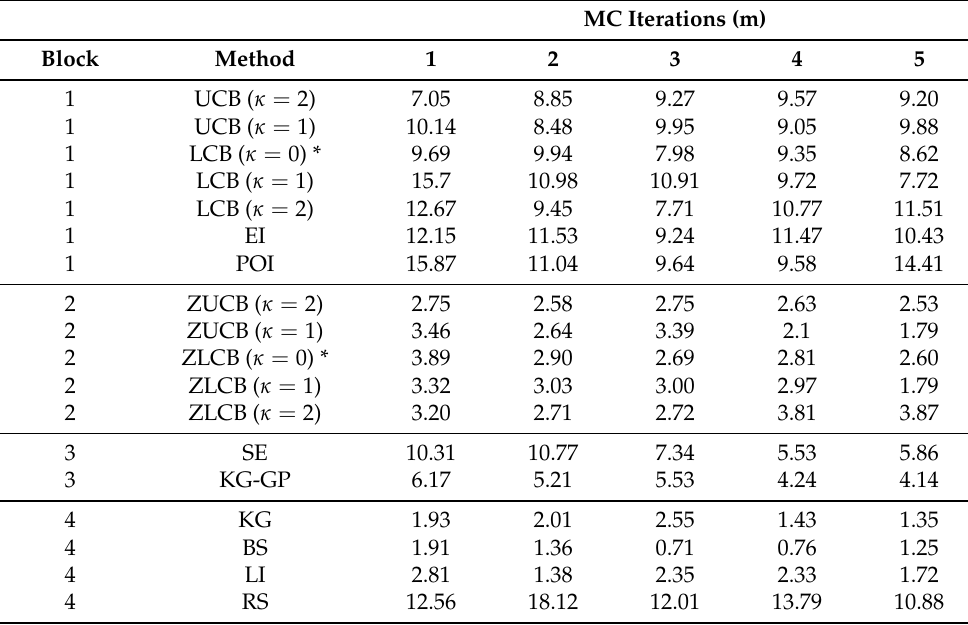
Table 3. Run number standard deviations, based on 25 runs in each case. * When κ = 0 the upper and lower CB methods are identical.